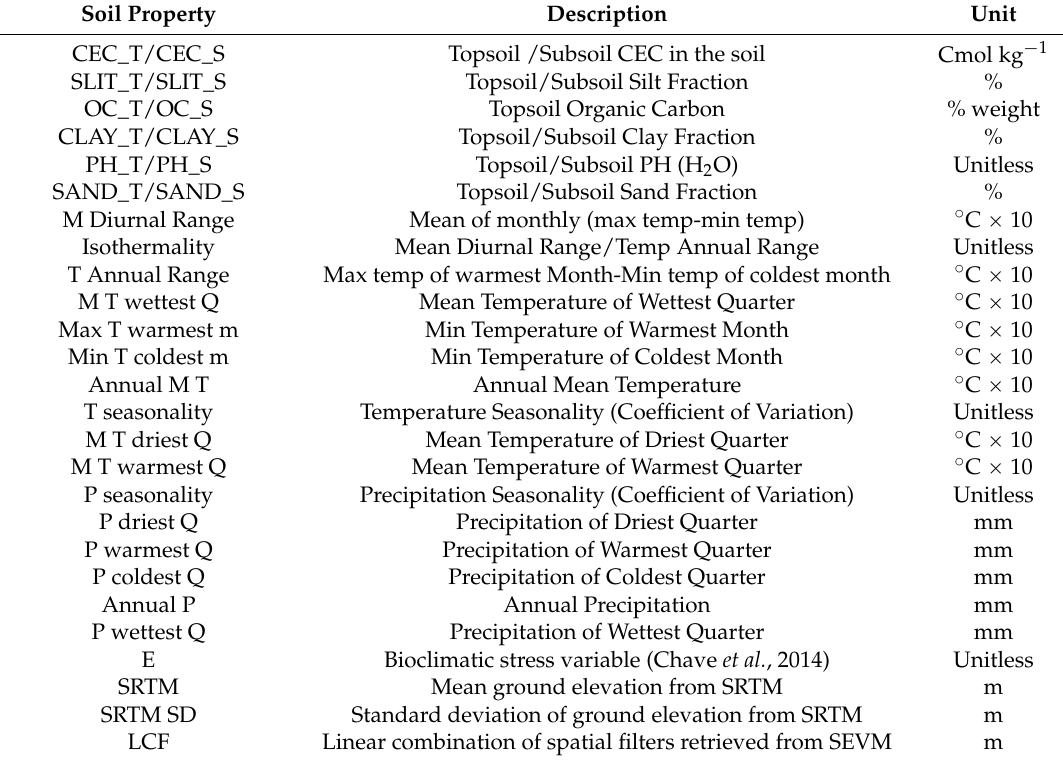
Table 1. Soil properties, bioclimatic variables, and geographical features used in the Tables 2 and 3 All values of soil properties were extracted from the HWSD database, and averaged into 0.5 ˝ ˆ 0.5 ˝ pixel